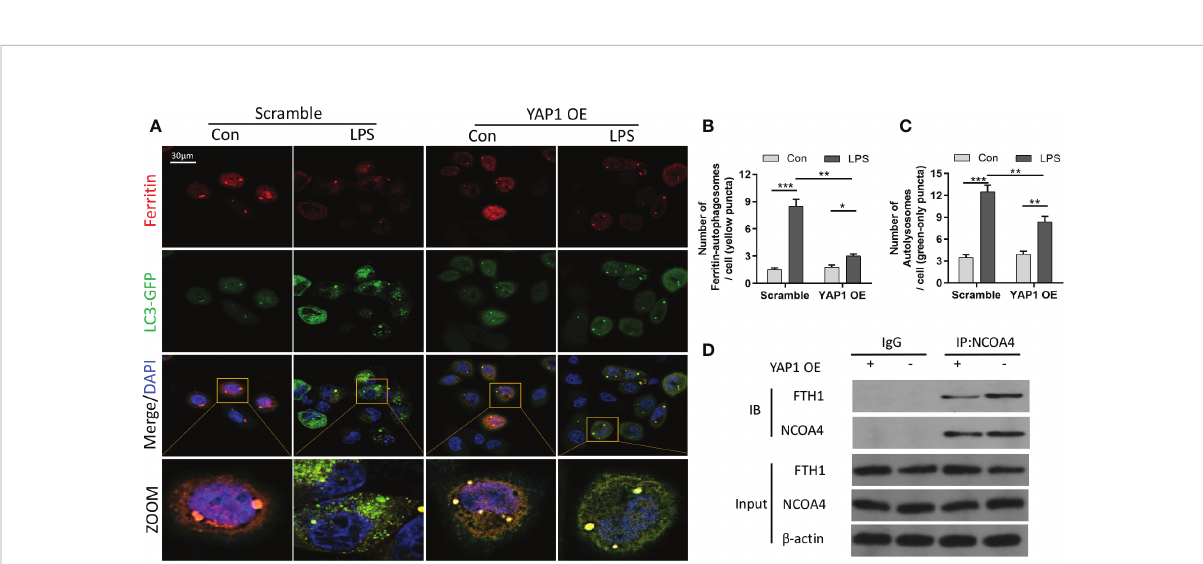
FIGURE 4 YAP1 inhibited ferritinophagy by disrupting the NCOA4 − FTH1 interaction. (A) Cells in the indicated groups were transfected with the LC3-GFP plasmid, and the autophagosome in cells presented green fl uorescence puncta. Representative confocal images of cells exhibited fl uorescent colocalization (yellow puncta) of ferritin (red fl uorescence) with LC3-GFP (green puncta). Cells were treated with LPS for 24 (h) (B) Fluorescence quanti fi cation of ferritin colocalizing with autophagosomes (LC3-GFP). The colocalization puncta per cell were calculated. (C) Fluorescence quanti fi cation of autophagosomes (LC3-GFP). The autophagosome puncta per cell were calculated. (D) Immunoprecipitation analysis of NCOA4 and FTH1 interaction in MLE-12 cells. IgG was used for control. Data are expressed as mean ± SD. n = 3; * p < 0.05, ** p < 0.01, *** p < 0.001.